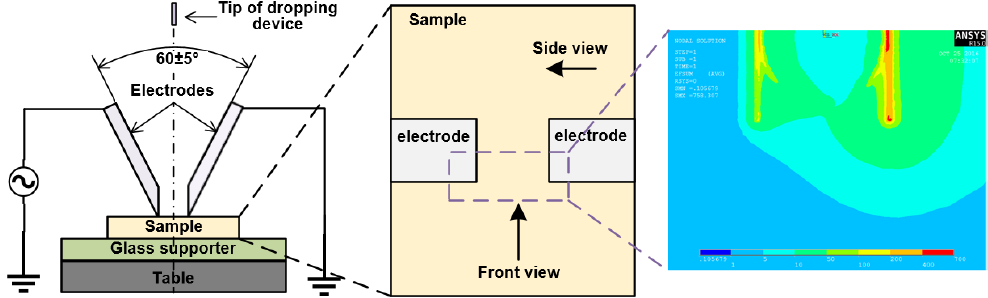
Figure 1. Schematic diagram of surface tracking measurement and electric field distribution near the electrodes.